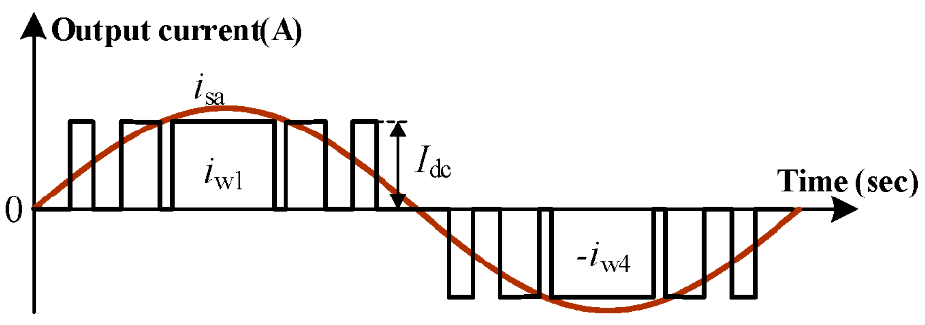
sinusoidal distribution, as shown in Figure 2. Since the LC filter is a second-order system, the harmonic components in the i sa can be suppressed effectively, which can ensure the quality of grid side current. The amplitude of the grid side current is determined by the modulation index.